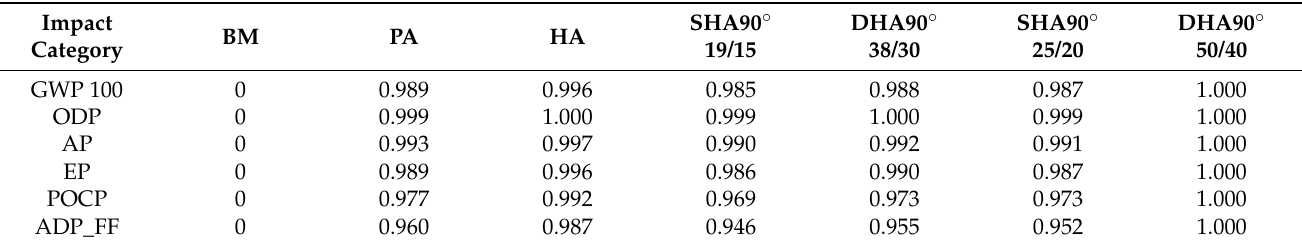
Table 8. Summarized standardized impact of sustainability indicators in the distinctive form arrange-